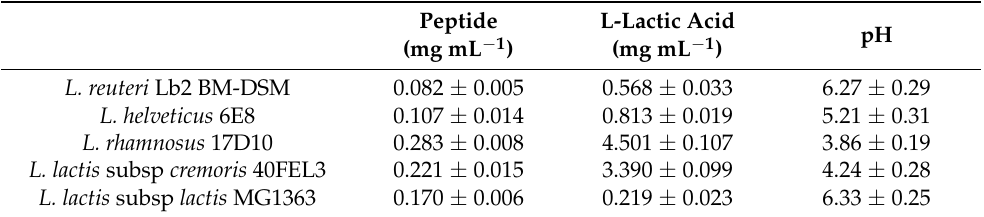
Table 1. Quantification of released peptides, L-lactic acid content, and pH after 24 h donkey milk fermentation by the five selected LAB strains.